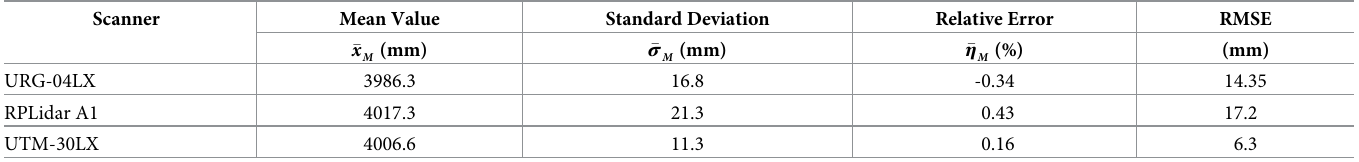
Table 2. Comparison of drift effects of 2D laser scanners at four meter distance.